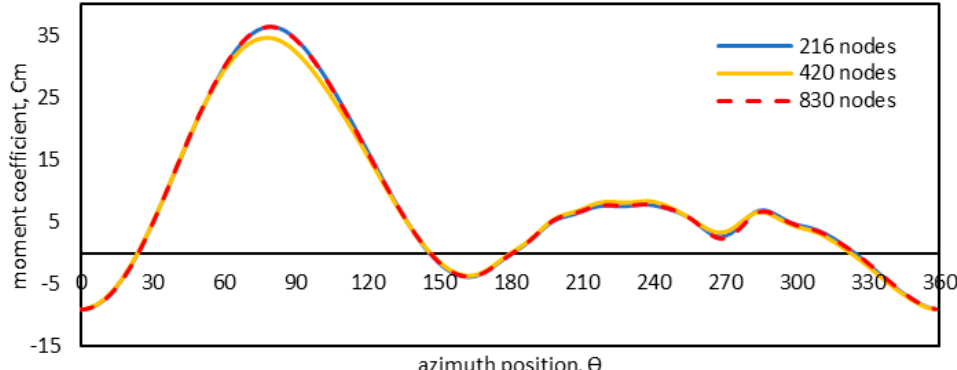
Figure 7. Torque plots for the coarse, medium and fine mesh.